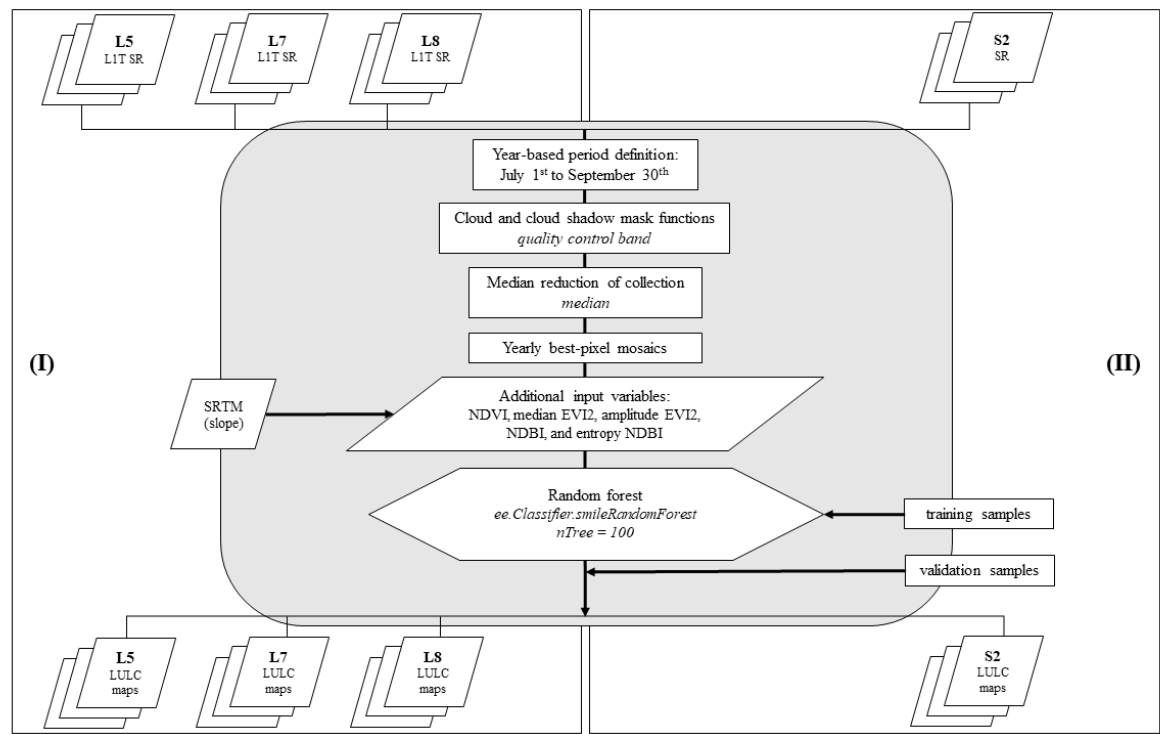
Figure 3. The workflow of the procedures with sensors: TM Landsat-5 (L5), ETM+ Landsat-7 (L7), OLI Landsat-8 (L8), and MSI Sentinel-2 (S2). For Landsat (LS) dataset: Collection 1, Tier 1, orthorectified surface reflectance (L1T SR). For Sentinel-2 dataset: surface reflectance (SR) Level-2A. Additional variables: Normalized Difference Vegetation Index (NDVI), Enhanced Vegetation Index 2 (EVI2), Normalized Difference Built-Up Index (NDBI), Shuttle Radar Topography Mission (SRTM).